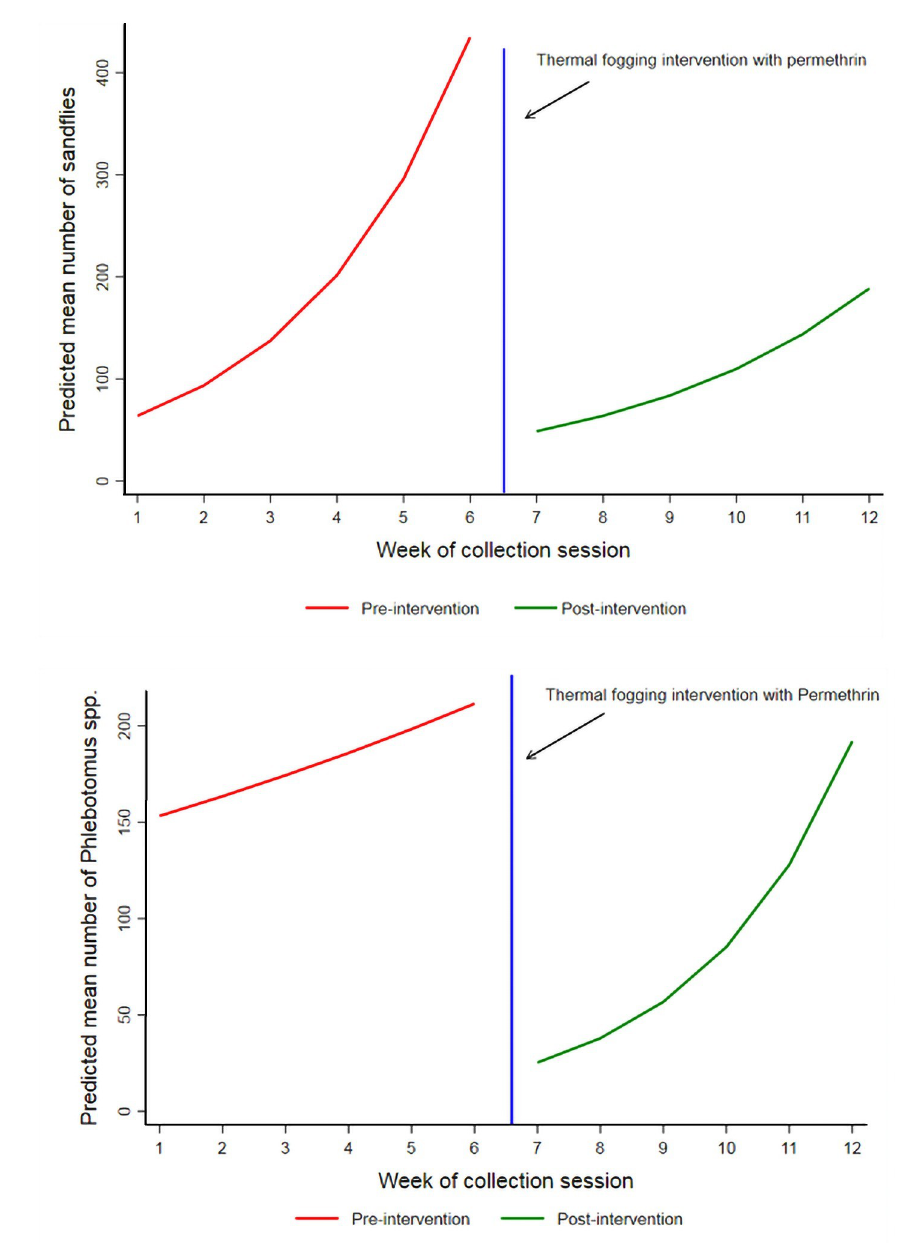
Fig 5. Predicted mean number (trend) of a) all sand flies and b) Phlebotomus spp . sand flies in the intervention site pre- and post- intervention using negative binomial regression a , Tayasir, Palestine, 2019 (S3 Data). a with robust standard errors and adjusted for the week of collection session